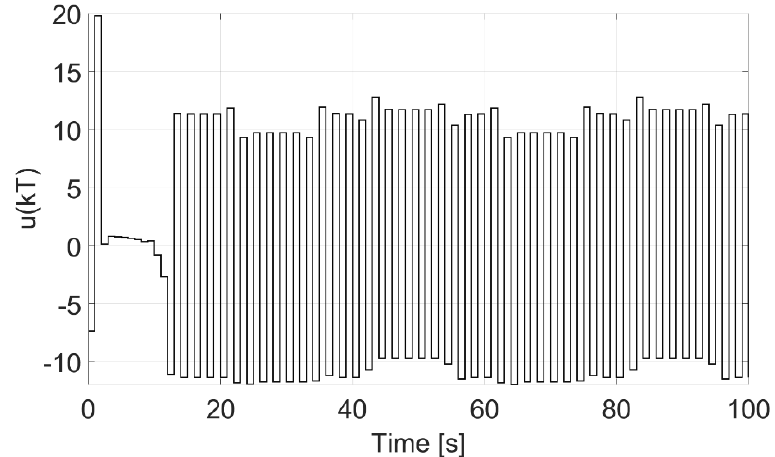
Figure 2. Control signal of the switching controller.